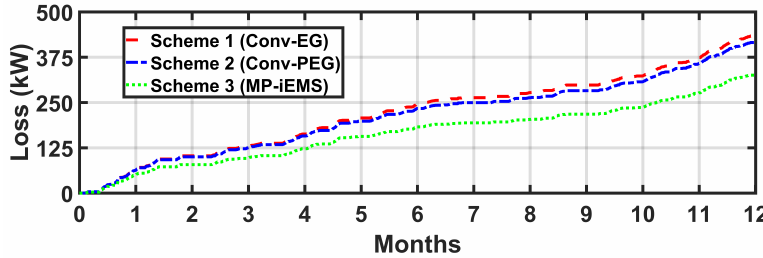
Figure 20. Total EV storage